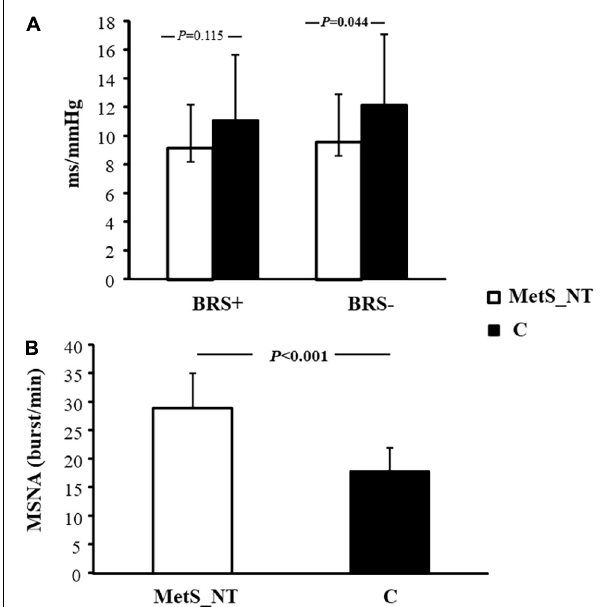
FIGURE 2 | Baroreflex sensitivity for increases (BRS+) and decreases (BRS − ) in spontaneous BP fluctuations (A) , and muscle sympathetic nerve activity